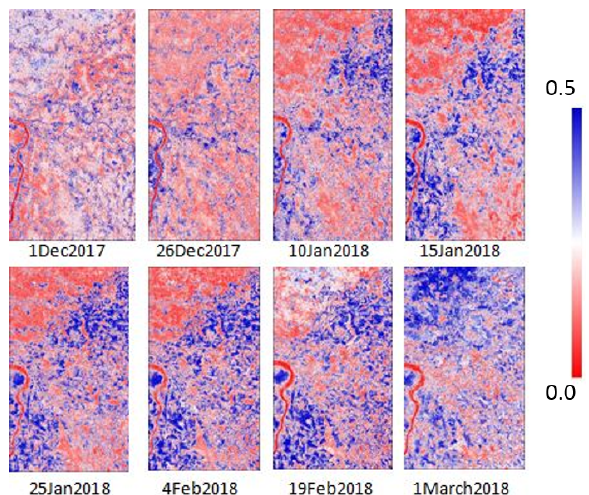
Figure 8. Spatio-Temporal changes of NDI45 in study area.